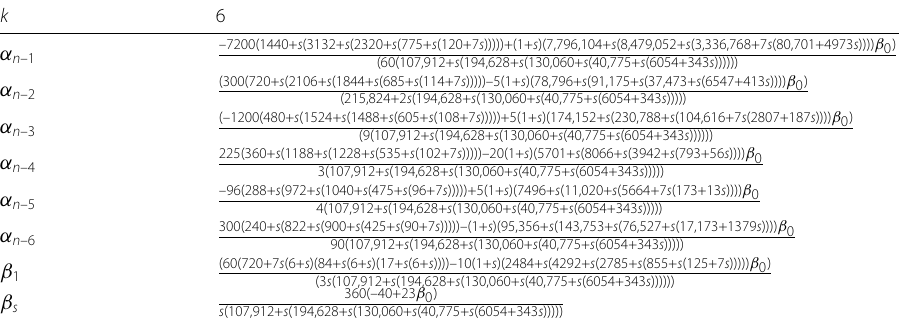
Table 4 The coefficients of method (2.2) for order